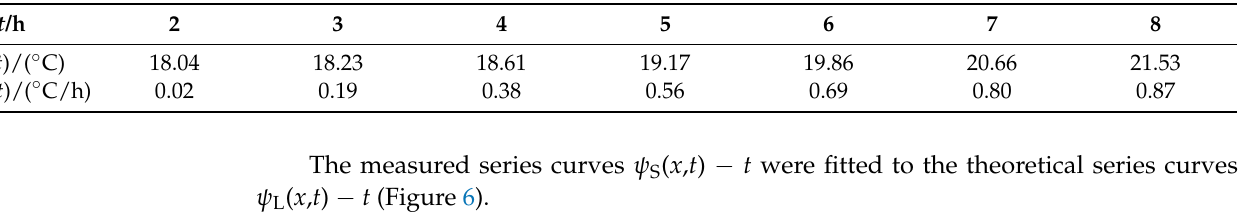
Table 5. Temperature measurements at x = 0.5 m.